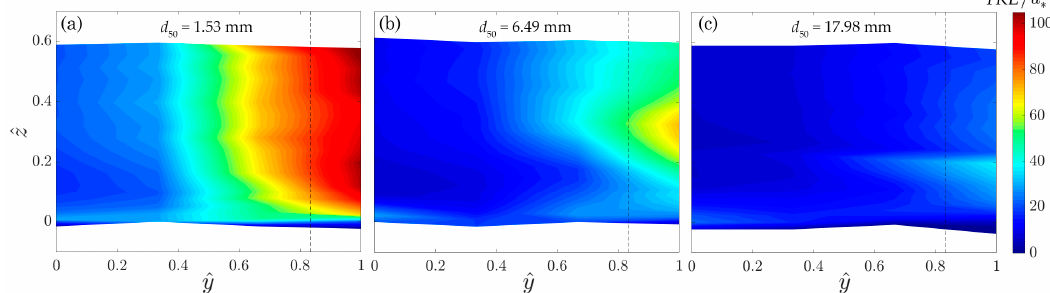
Figure 19. Contours of the dimensionless TKE on the lateral plane (from D to A) for ( a ) Run 1, ( b ) Run 2, and ( c ) Run 3. The black broken line indicates the cylinder location.